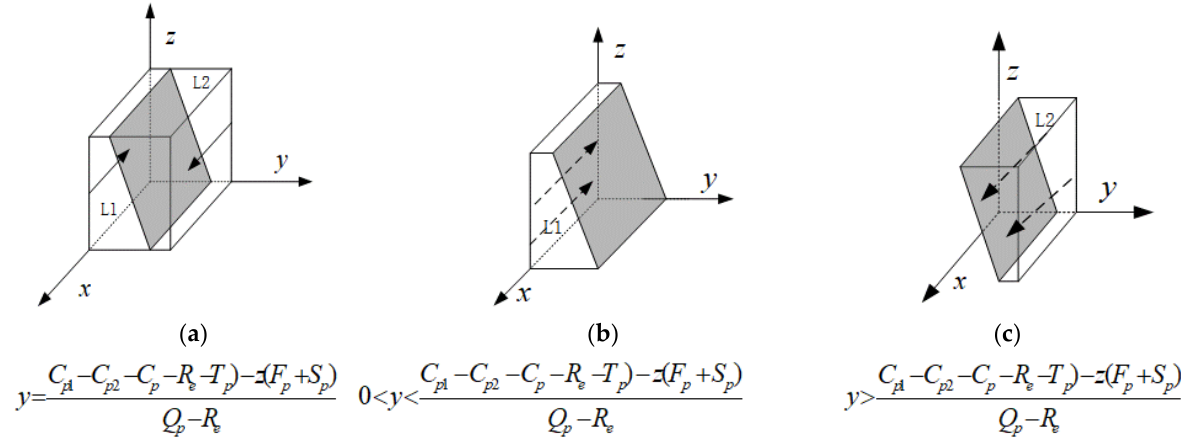
Figure 1. The phase diagram of high- pollution enterprises’ replication dynamics .